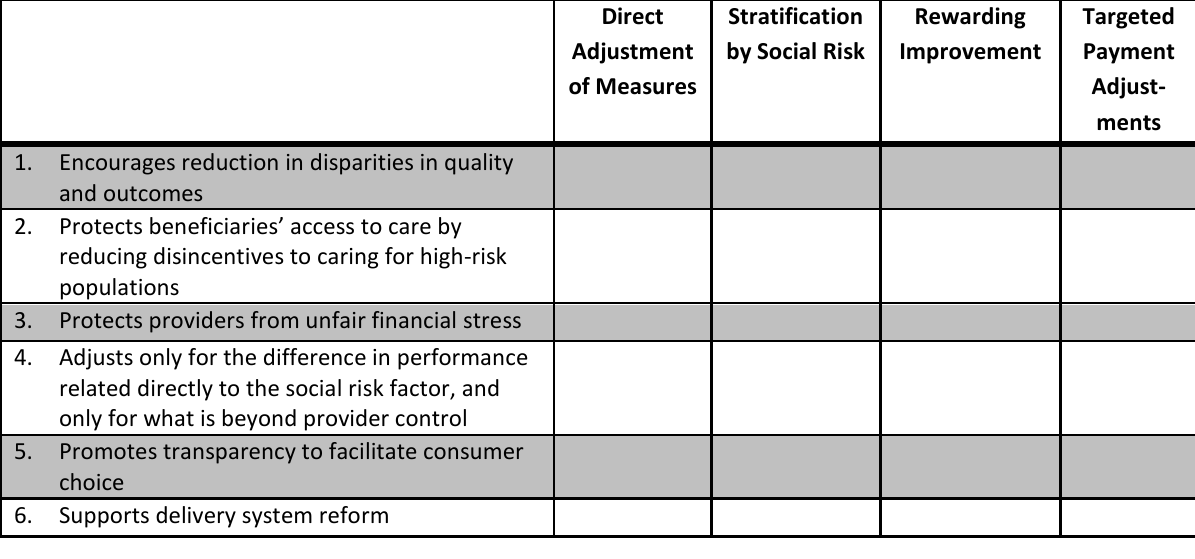
Table 1.2: Policy Criteria and